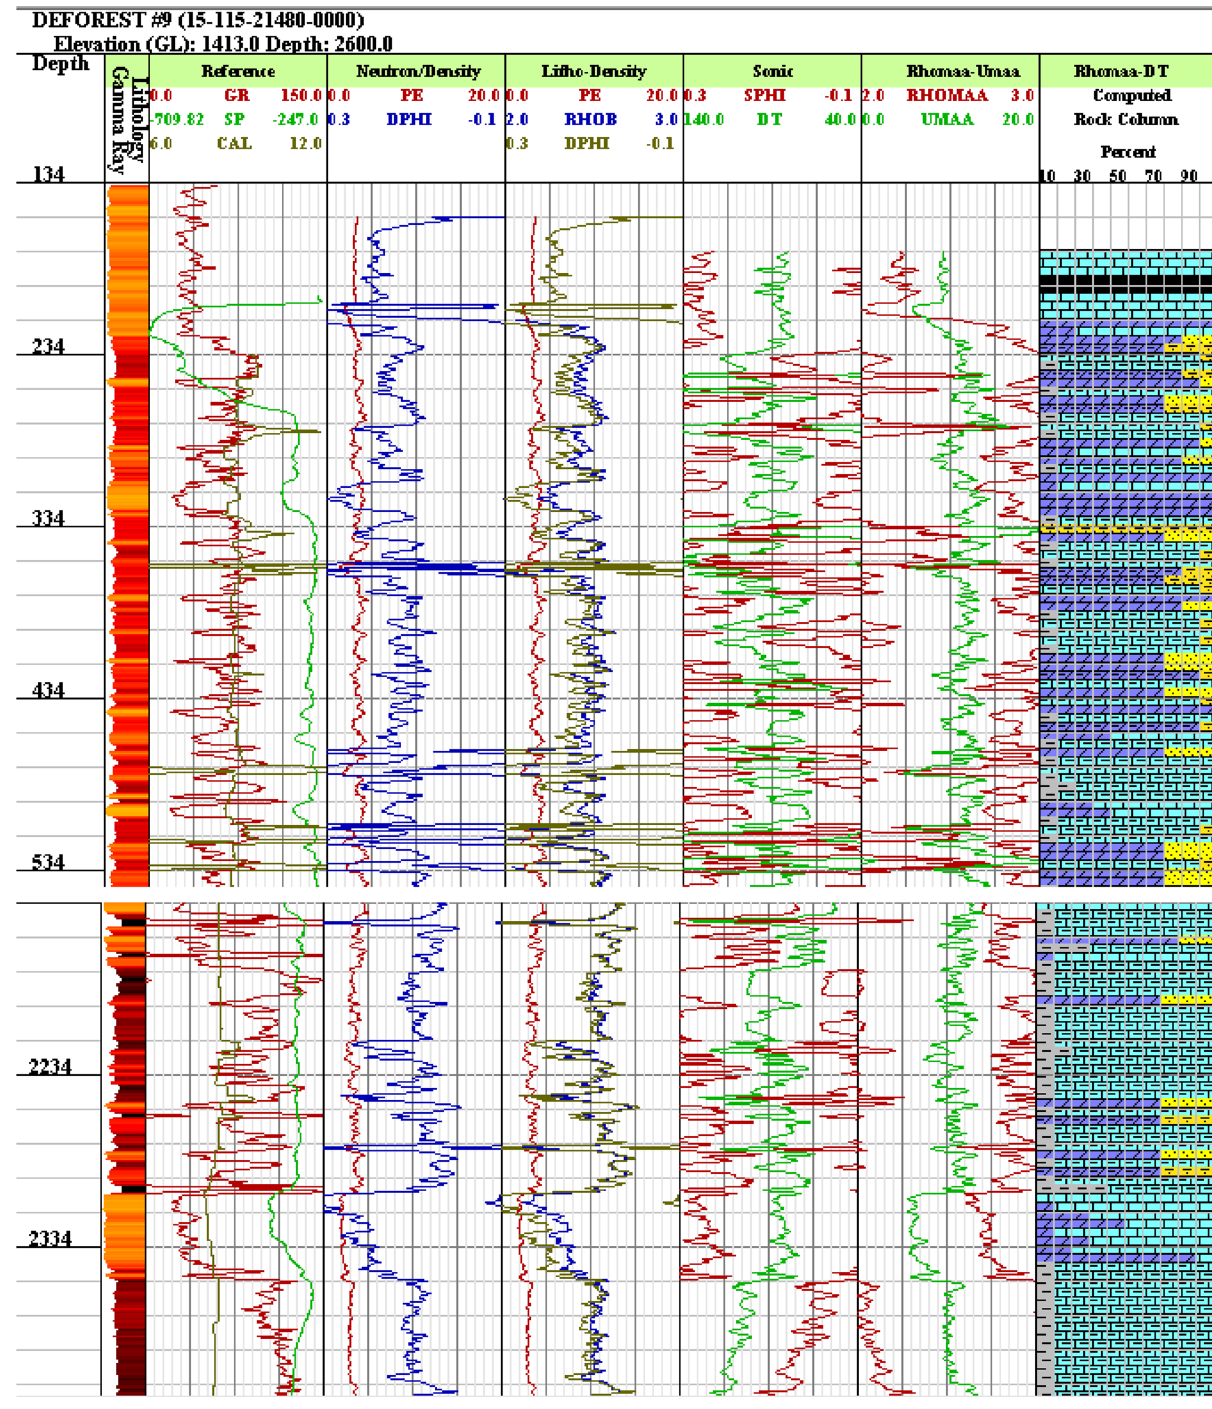
Fig. 3 Well logs of Kansas hydrocarbon-producing Deforest well (KGS